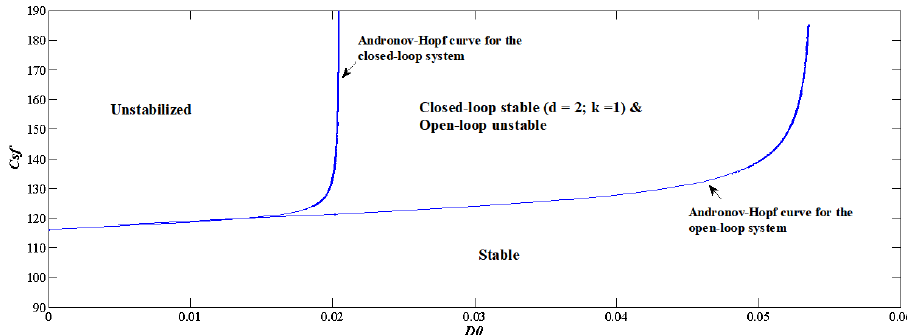
Figure 7. Two-parameter continuation diagram for the designing parameters.